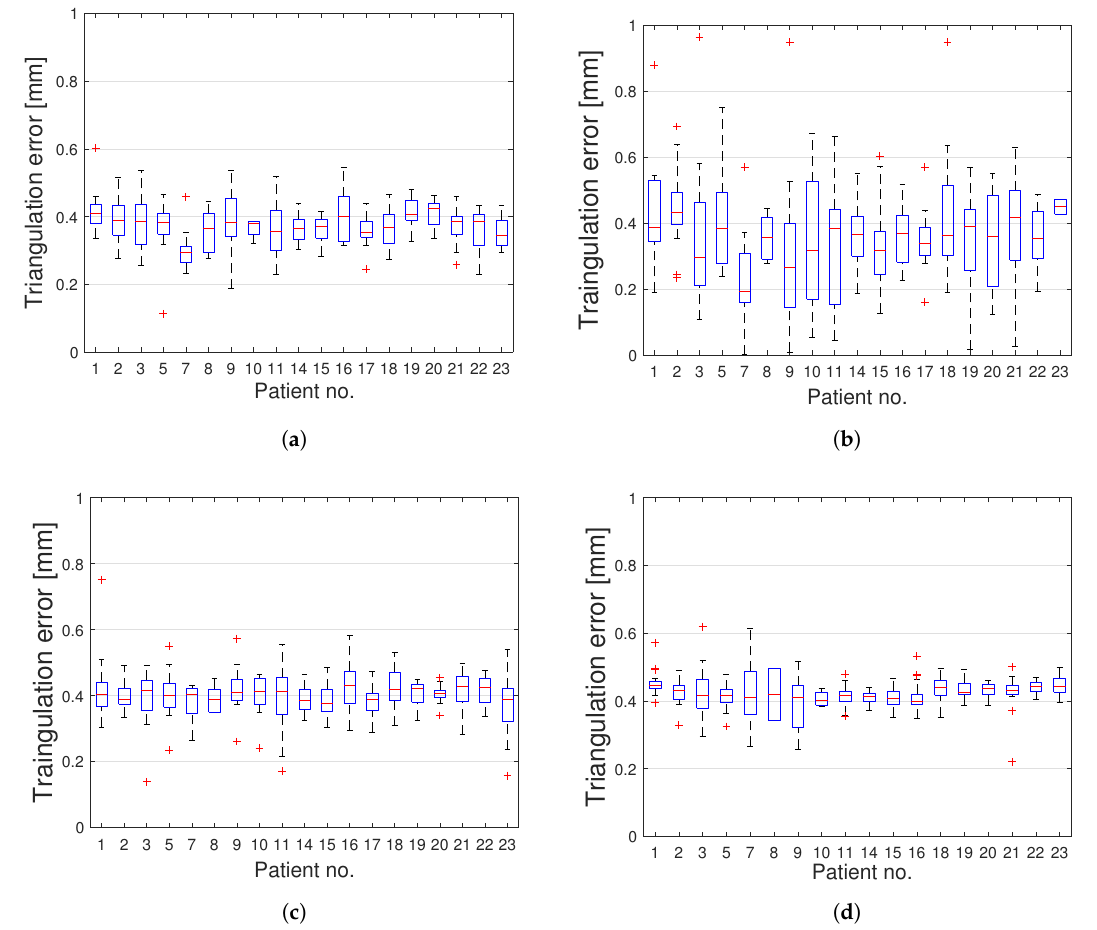
Figure 11. Boxplots comparing the total mean triangulation error in 23 patients when using SURF ( a ), MSER ( b ), FAST ( c ), ORB ( d ) as feature detectors. Upper and lower limits of the box represent 75th and 25th percentiles, respectively. The median is represented by a line transecting the box. Whiskers represent the max and min values. Outliers are plotted using the ’+’